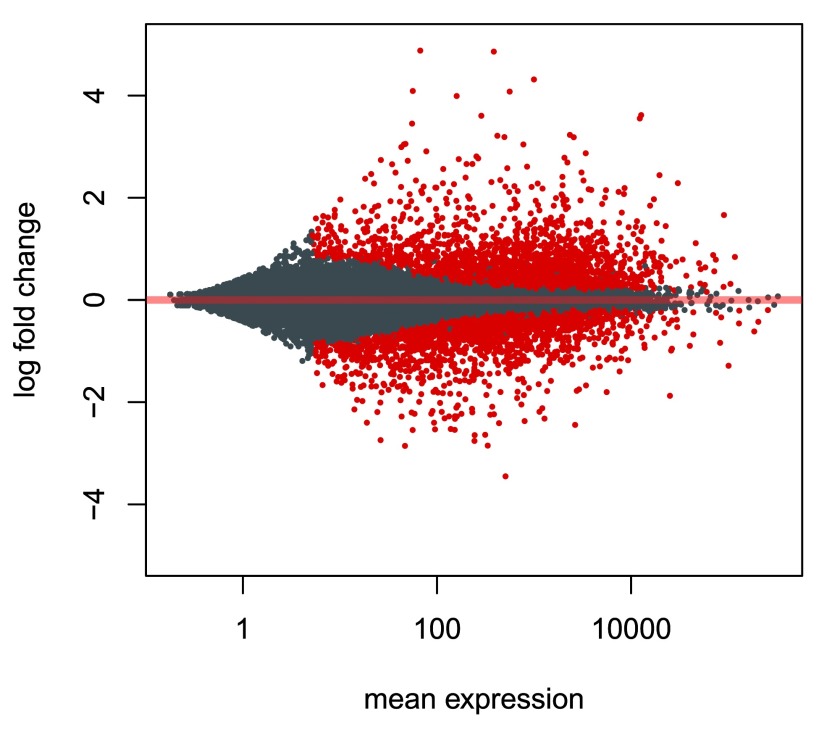
An MA-plot of changes induced by treatment.The log2 fold change for a particular comparison is plotted on the y-axis and the average of the counts normalized by size factor is shown on the x-axis (“M” for minus, because a log ratio is equal to log minus log, and “A” for average). Each gene is represented with a dot. Genes with an adjusted
p value below a threshold (here 0.1, the default) are shown in red.